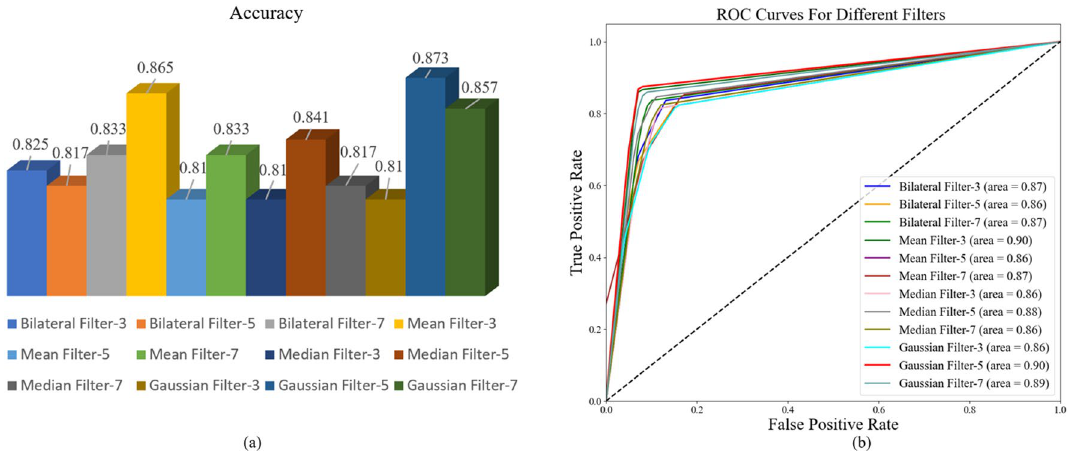
Figure 4. ( a ) Accuracy of HCCANet based on different filters. ( b ) AUC values for HCCANet based on different